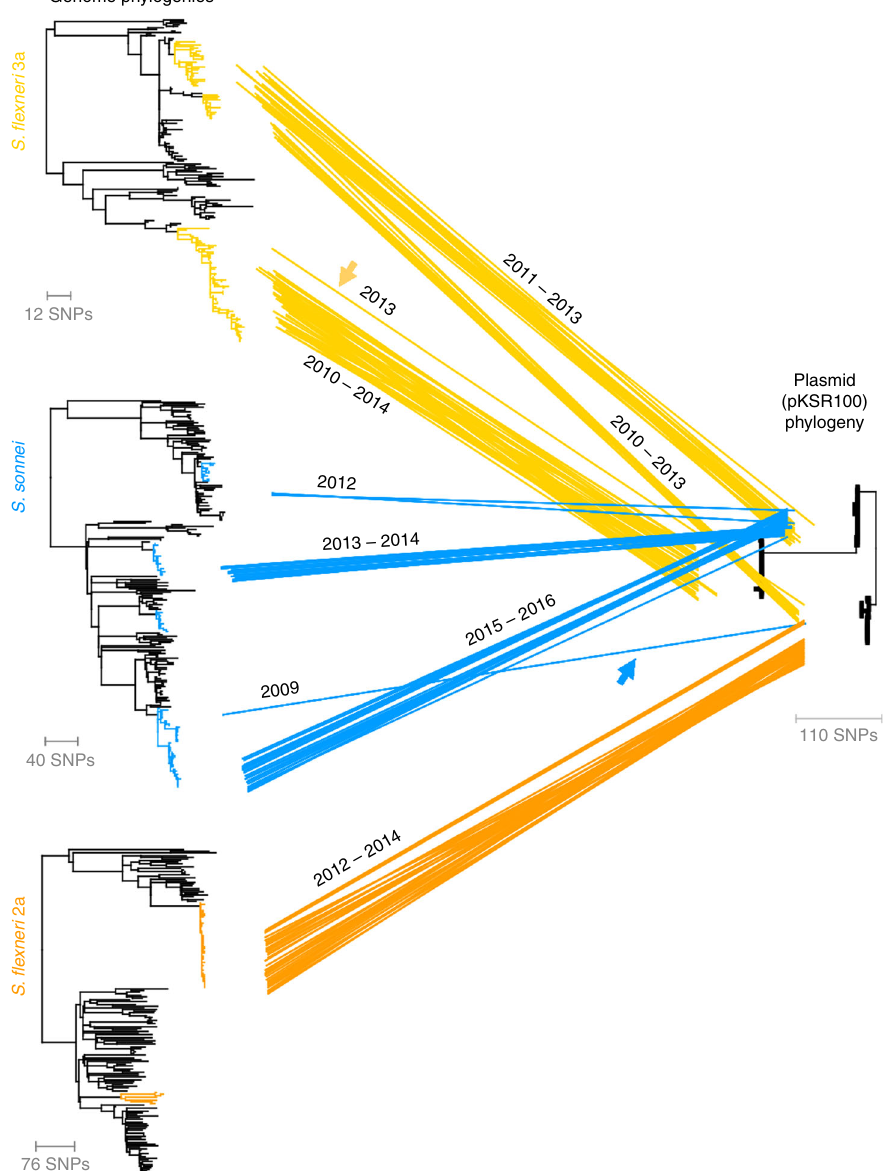
Fig. 4 Horizontal transmission of pKSR100. Three whole-genome phylogenies for MSMA S. fl exneri 3a, and S. fl exneri 2a and S. sonnei are shown leftmost with successful and MSMA sublineages (respectively) highlighted in colour. The plasmid tree is a phylogeny of pKSR100 constructed from isolates containing pKSR100. Scale bars in single nucleotide polymorphisms (SNPs) are shown below each phylogeny. Individual isolate genome positions are joined to their plasmid phylogenetic position by intervening coloured lines. Two examples of horizontal transmission are indicated by arrows coloured according to the species. A time-series animation of this fi gure showing change over time and a static explanatory model are available elsewhere (see: Supplementary Movie 1 and Supplementary Fig.